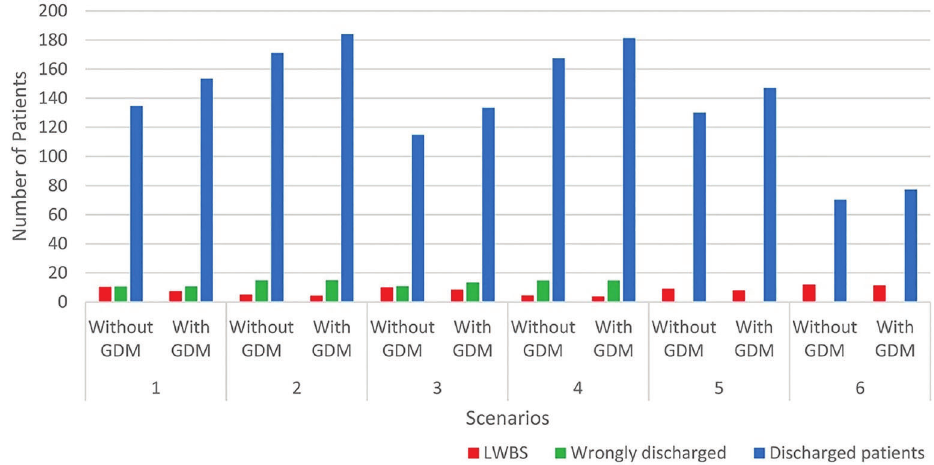
Figure 7. Comparison of leaving without being seen (LWBS), number of wrongly discharged patients and total number of discharged patients before and after applying group decision-making (GDM) in different